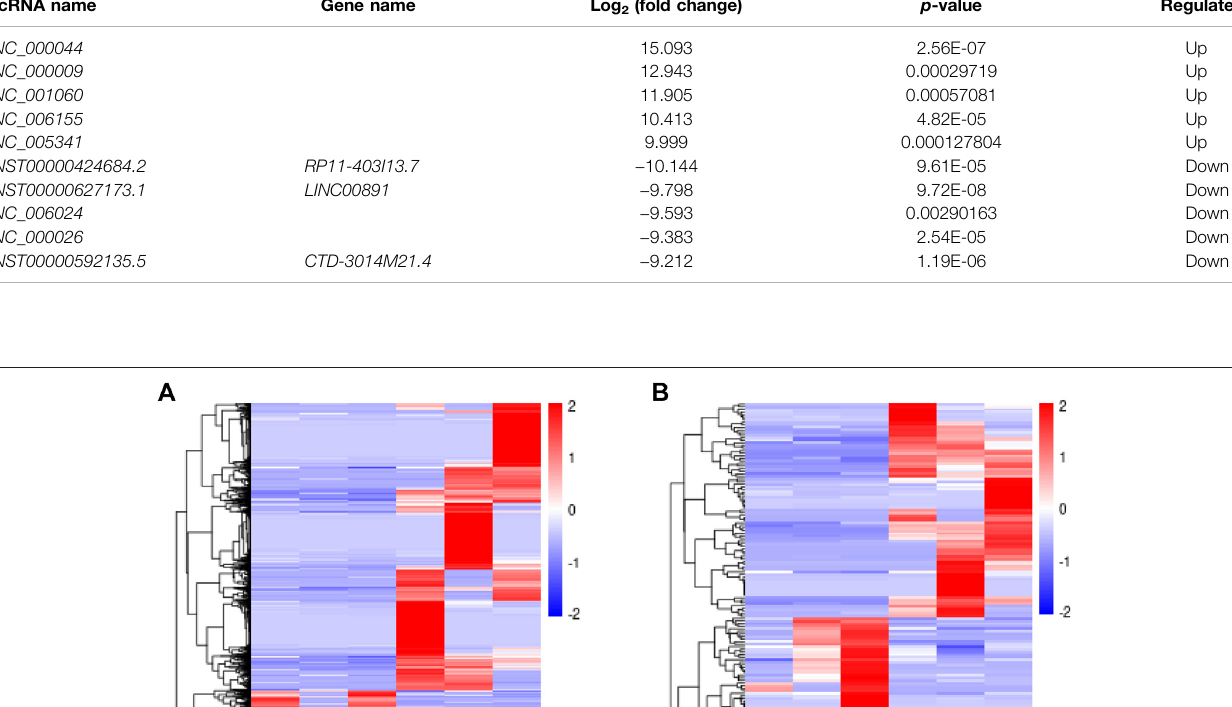
Frontiers in Genetics |